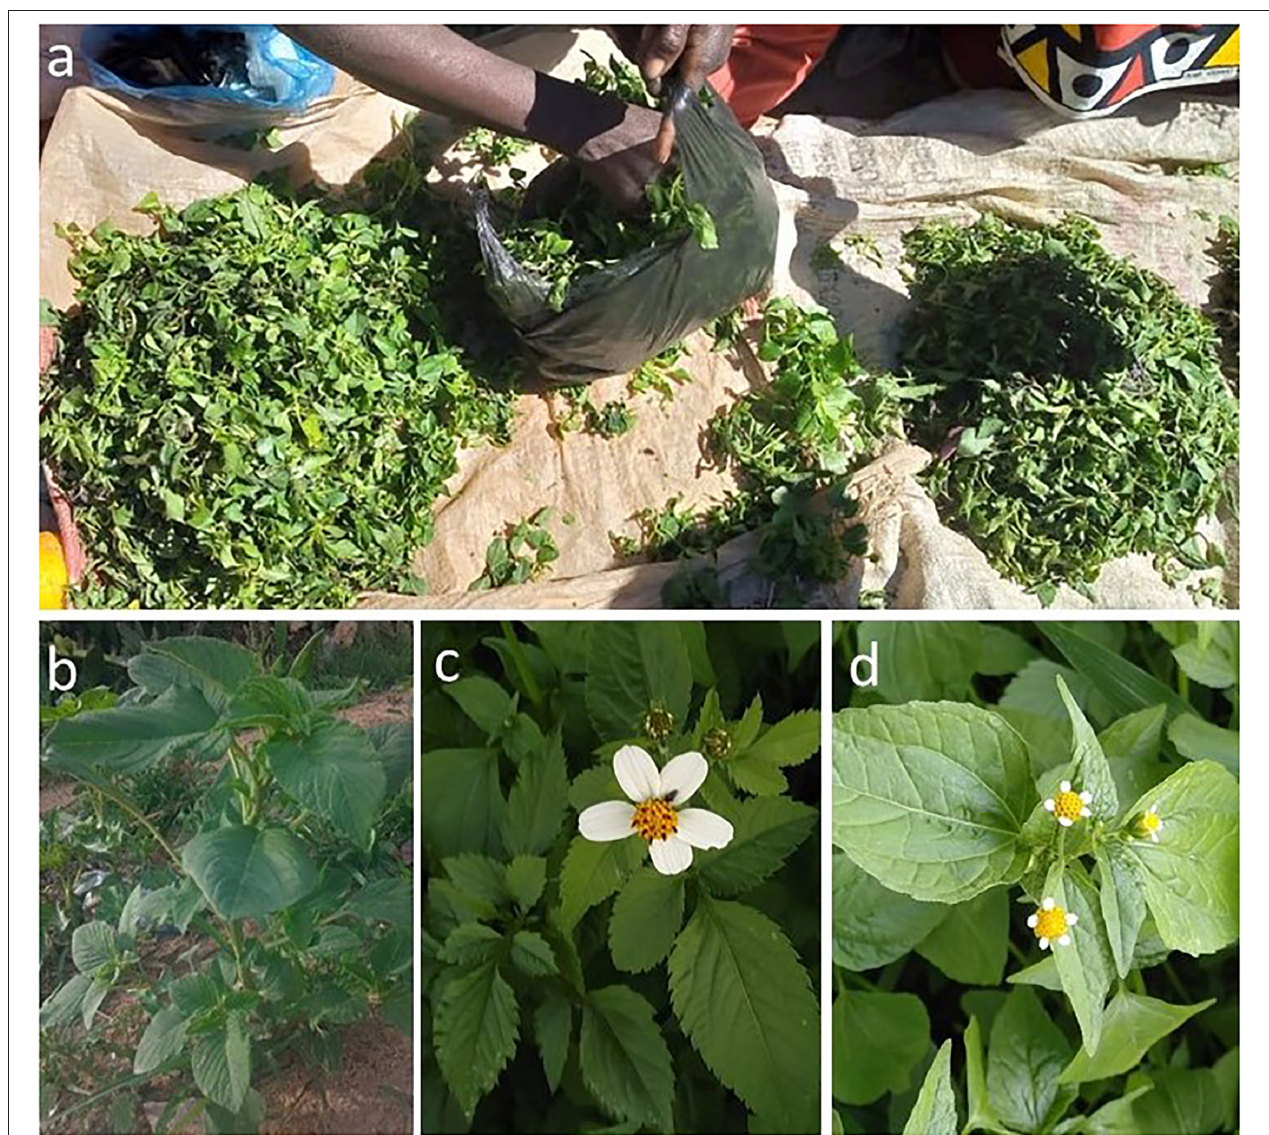
FIGURE 2 | Species of traditional leafy vegetables sold at Lubango markets. (a) Mixture in piles, at the market; (b) Amaranthus hybridus ; (c) Bidens pilosa and (d) Galinsoga parviflora . Photos by Ruth Francisco (a) and F. Lages (b–d)